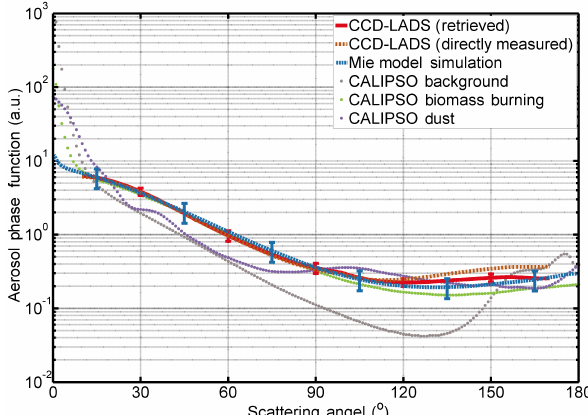
Figure 7. Comparison between aerosol phase function obtained from CCD-LADS measurements (red solid line shows the result es- timated with the retrieval algorithm, brown dashed line shows that estimated directly with the measurements), modelled with modi- fied Mie model (blue dashed line) and offered by previous studies with CALIPSO (different colours of dotted lines represent different aerosol types).